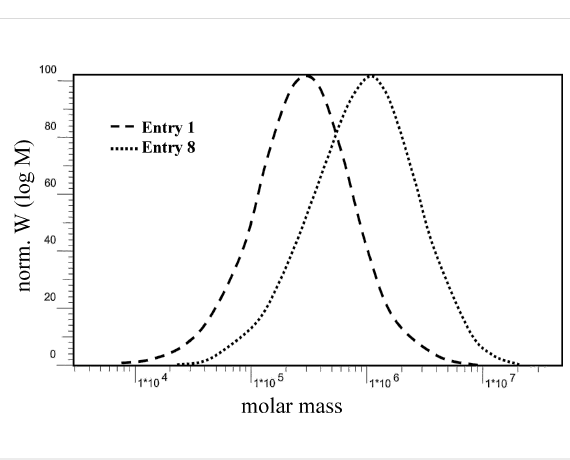
Figure 3: Comparison of GPC traces of polyethylene produced by 1 /PMAO and 8 /PMAO respectively (entries 1 and 8 in Table